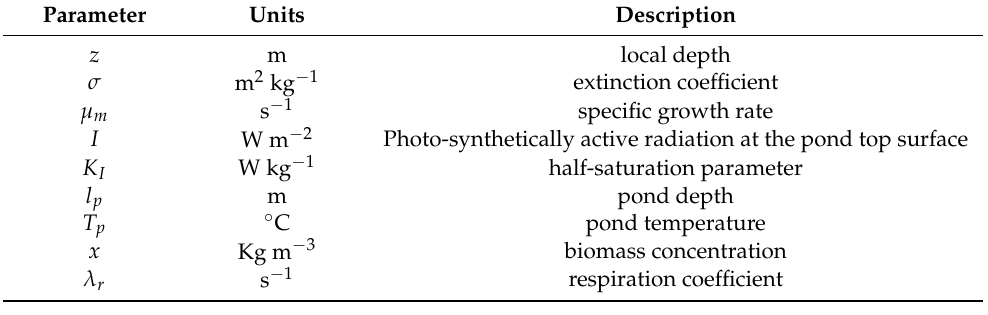
Table 2. Productivity model parameters.